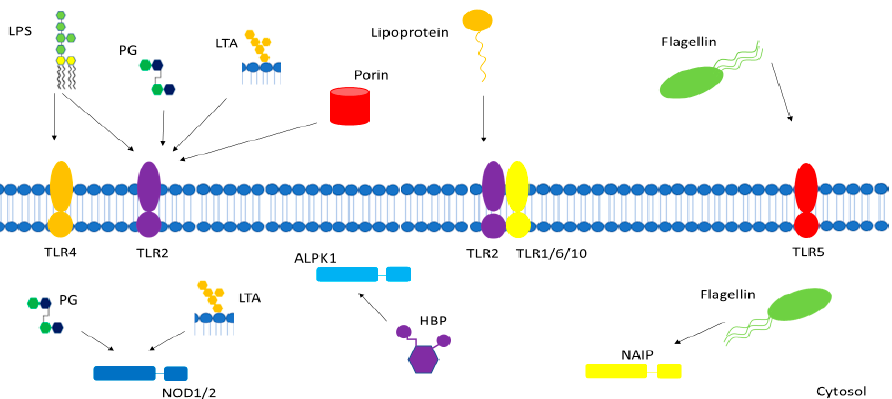
Figure 1. Gram-positive and Gram-negative bacterial pathogen-associated molecular patterns (PAMPs) interact with various membrane-bound and cytosolic receptors within the host cell. LPS—lipopolysaccharide, PG—peptidoglycan, LTA—lipoteichoic acid, TLR—toll-like receptor, NOD—nucleotide-binding oligomerization domain-containing protein, NAIP—NOD-like receptor apoptosis inhibitory protein, HBP—heptose-1,7-bisphosphate, ALPK1—alpha-kinase 1.